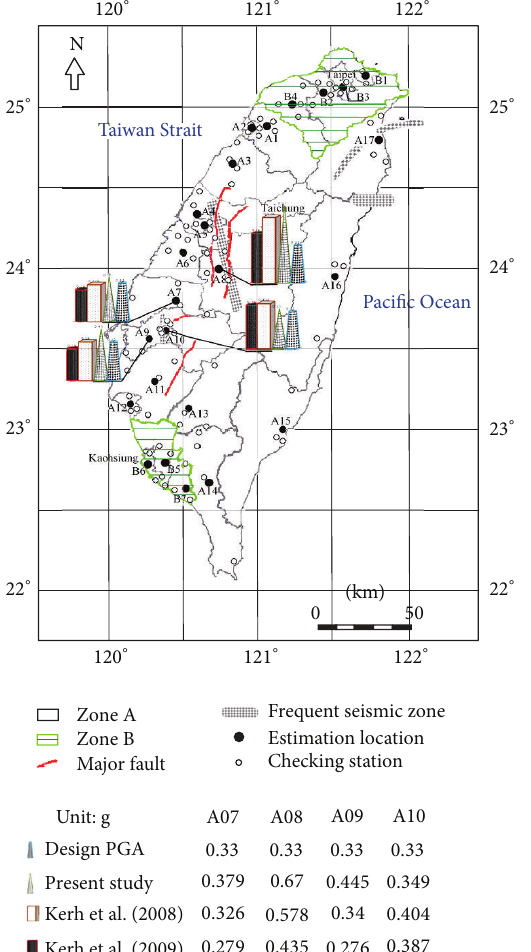
Figure 9: Location of identified potential hazardous subdivision zones.